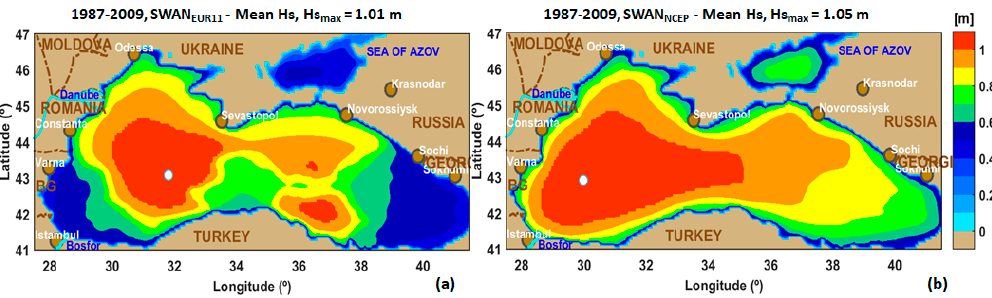
Figure 9. Spatial distribution of the mean significant wave height ( Hs ) over the period 1987–2009: SWAN EUR11 results ( a ) and SWAN NCEP results ( b ). The position of the maximum value of the mean Hs field is indicated by a white circle.